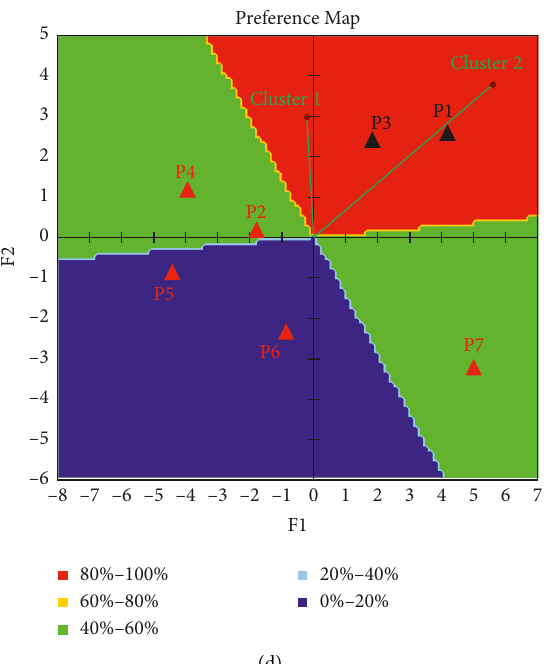
Figure 4: Sensory evaluation results of beers. (a) PCA biplot of quantitative descriptive analysis (QDA) of beers. (b) PCA plot constructed with bootstrap ellipses for the QDA data of beers. (c) Dendrogram of consumer clusters obtained by agglomerative hierarchical clustering analysis. (d) External preference mapping of beers achieved using